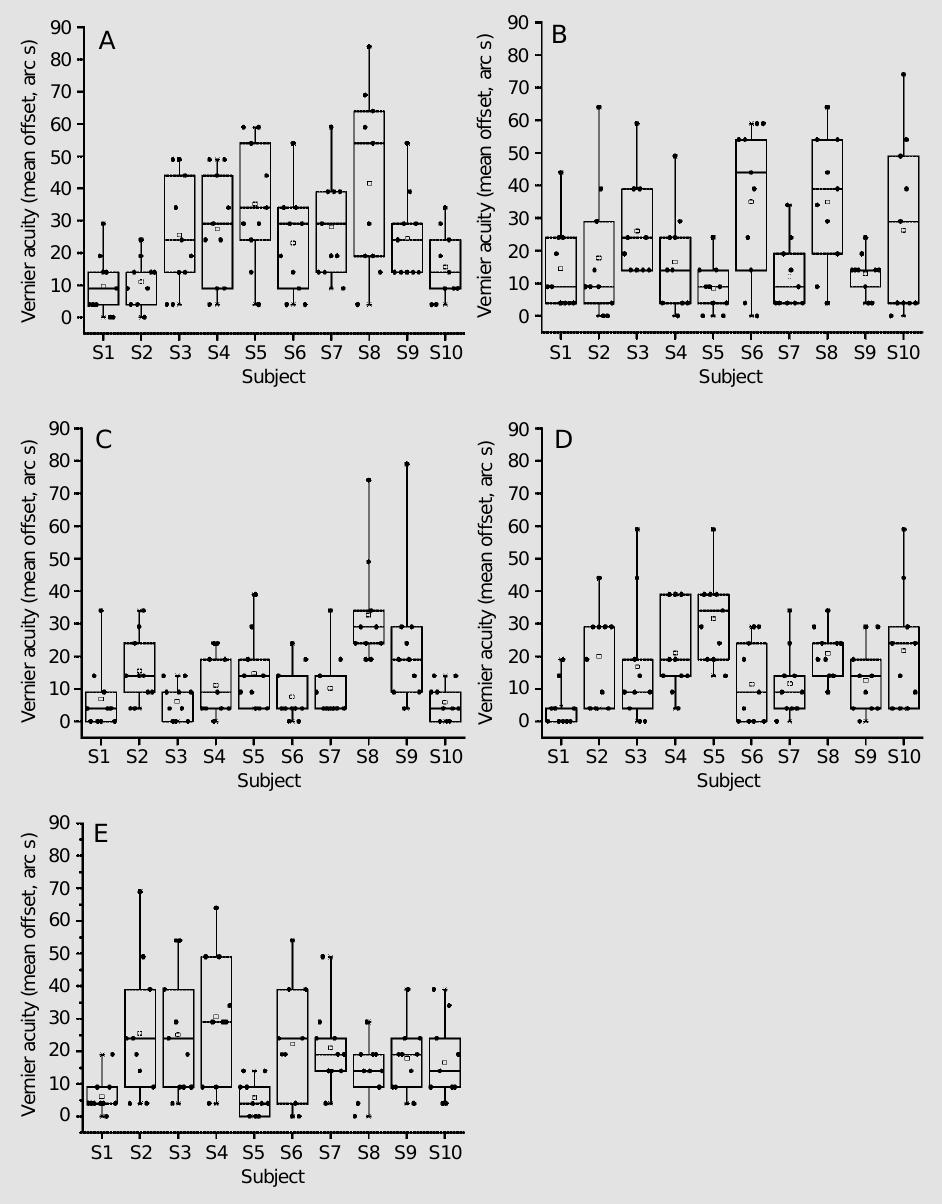
Figure 2. Vernier acuity trials of individual subjects in differ- ent age groups. A , 5-10 years; B , 11-20 years; C , 21-30 years; D , 31-40 years, and E , 41-50 years. The horizontal lines in the box denote the 25th, 50th and 75th percentiles. The error bars denote the 5th and 95th per- centiles. The two symbols be- low the 5th percentile error bar denote the 0th and 1st percen- tiles. The two symbols above the 95th percentile error bar de- note the 99th and 100th per- centiles. The square symbol in the box denotes the mean of the column of